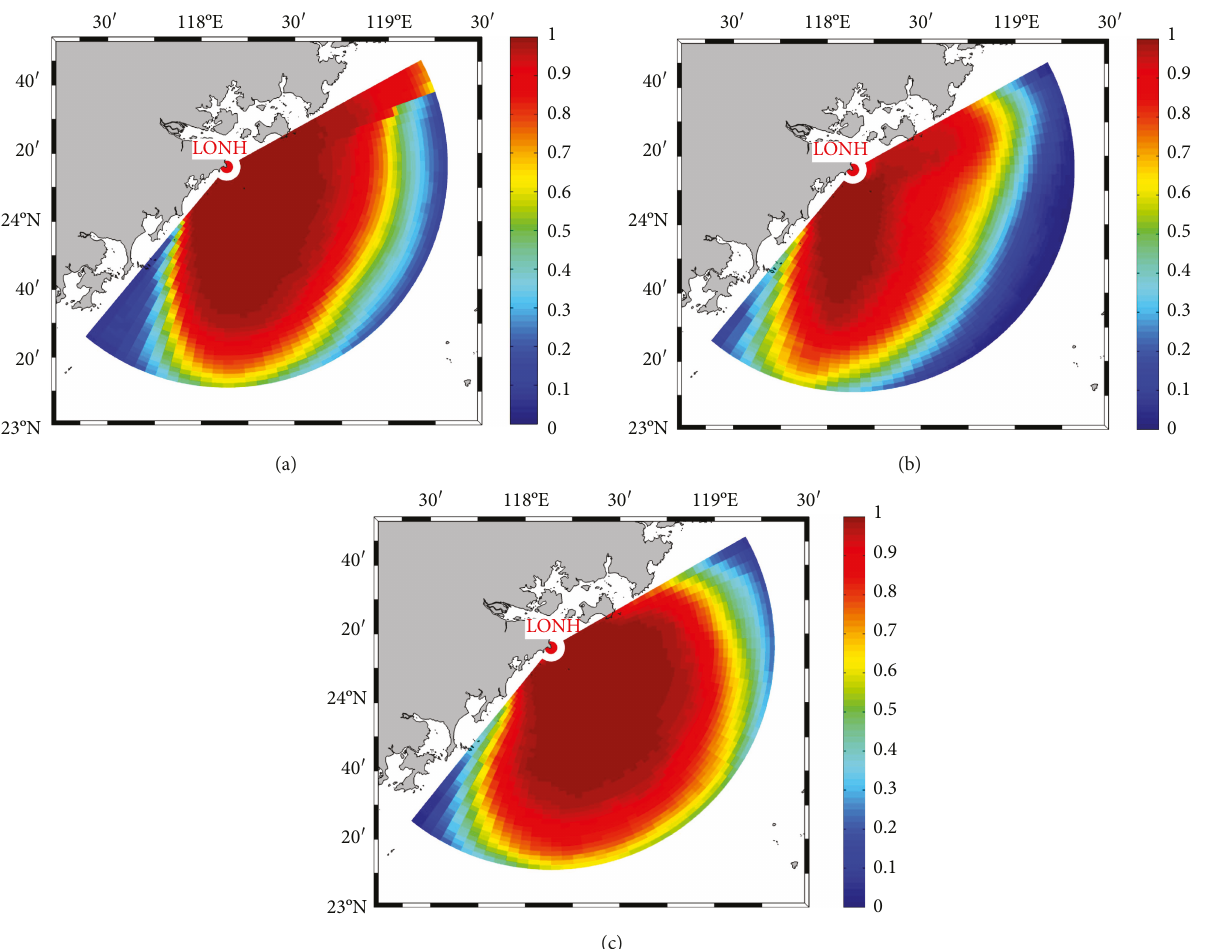
Figure 8: Temporal coverage rate of valid radial currents for LONH site with MCL antenna 1 (a), MCL antenna 2 (b), and dual MCL antenna system